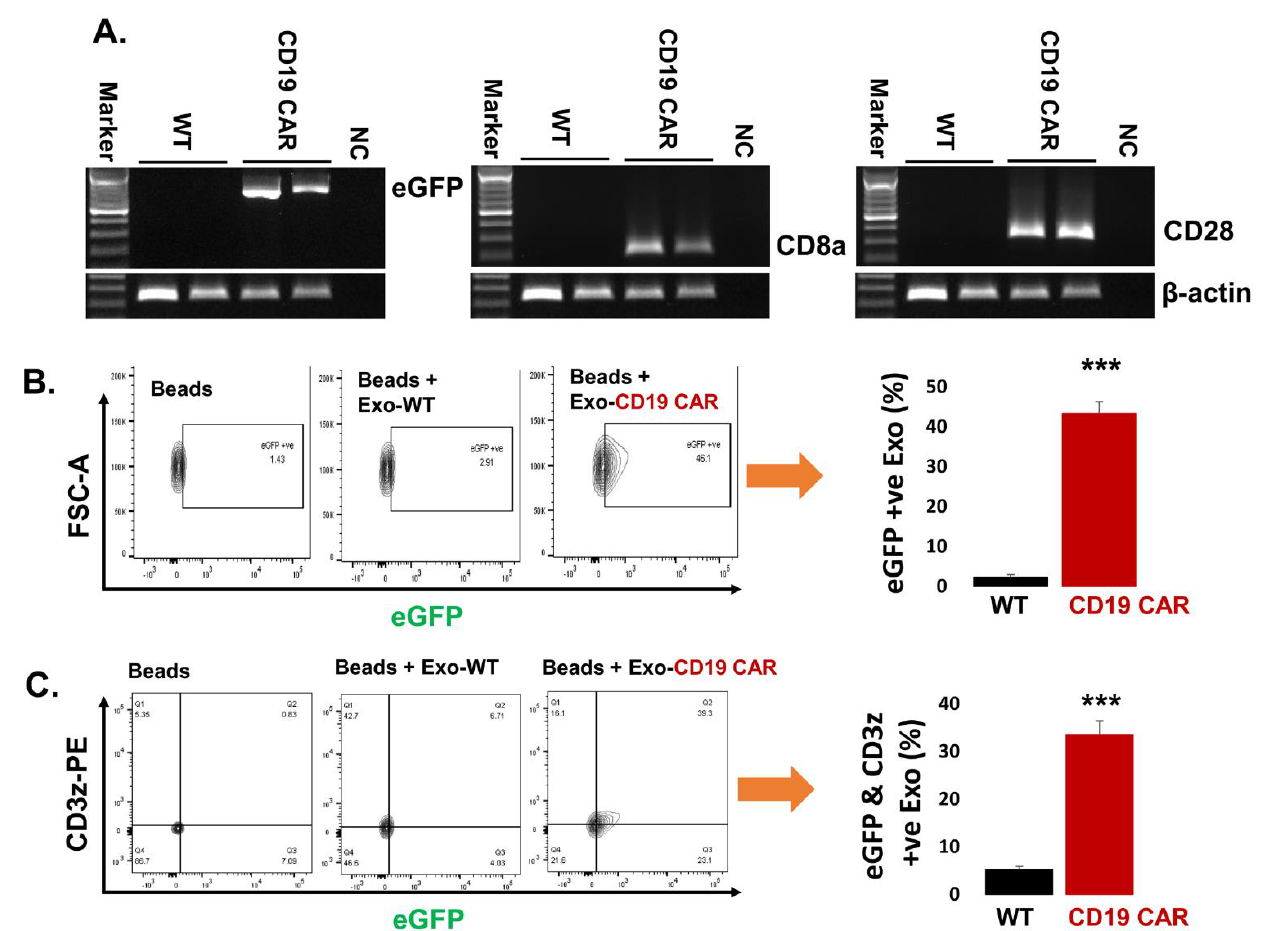
Figure 4. Confirmation of CD19 CAR molecules expression in harvested exosomes. ( A ) Agarose electrophoresis gel demonstrating Exo-CD19 CAR are positive for eGFP, CD8a, and CD28 mRNA expression while Exo-WT are negative for each of the markers. The β -actin band is same for each gene of interest because same sample/cDNA was used for PCR amplification of eGFP, CD8a, and CD28. ( B ) Flow cytometry contour plot demonstrating Exo-CD19 CAR expressing eGFP (unstained) compared with Exo-WT (control), and bar graph demonstrating cumulative data ( n = 3 independent experiments). Exo-WT and Exo-CD19 CAR were coated with CD63 antibody capture beads. ( C ) Flow cytometry showing co-expression of eGFP with CD3z in Exo-CD19 CAR compared to Exo-WT (control), and bar graph demonstrating cumulative data (three replicates). Exo-WT and Exo-CD19 CAR were attached with CD63 antibody capture beads followed by staining with CD3z antibody. P-value (*** p <